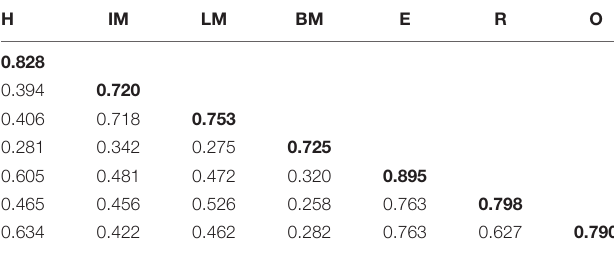
TABLE 3 | The discriminate validity index summary for measurement